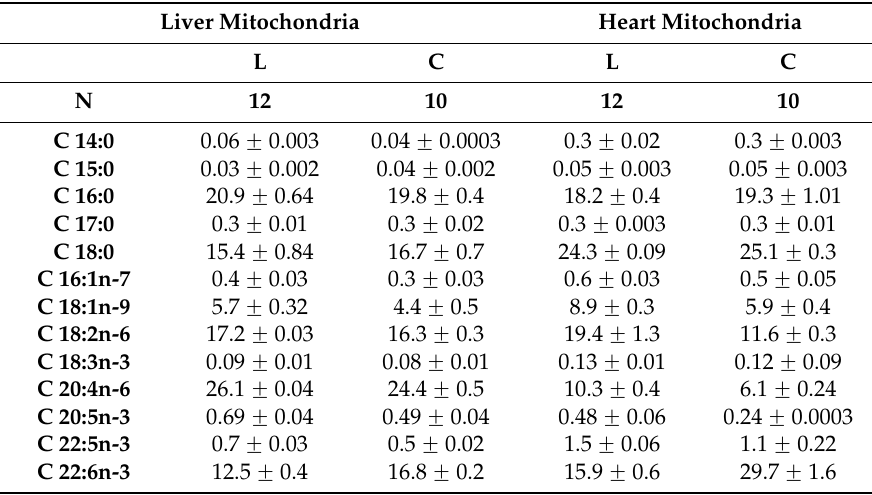
Table 2. Fatty acid composition of phospholipids in liver and heart mitochondria of lactating (L) and non-lactating control females (C). Values are given in weight %, means ˘ SEM.